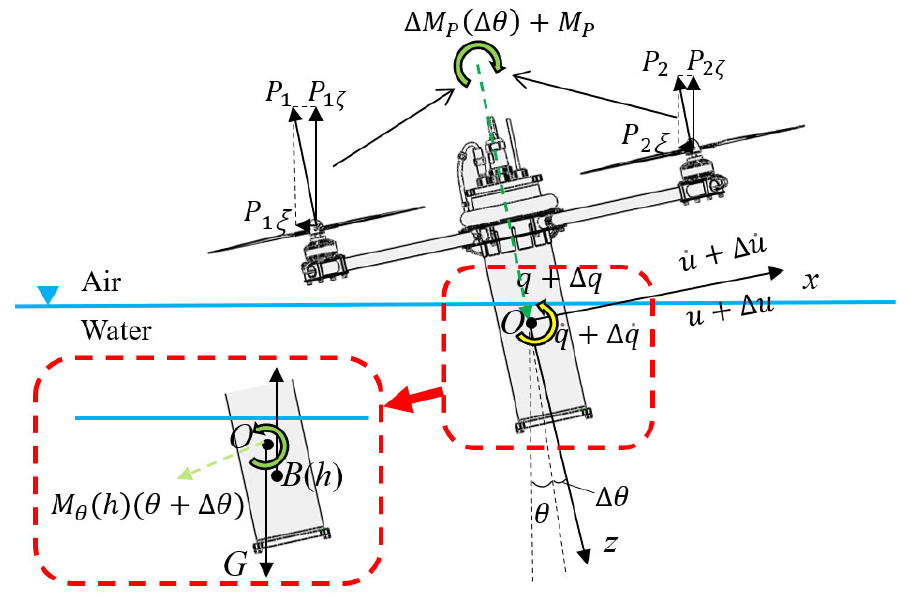
Figure 7. Dynamical force analysis in the ξ E ζ plane.